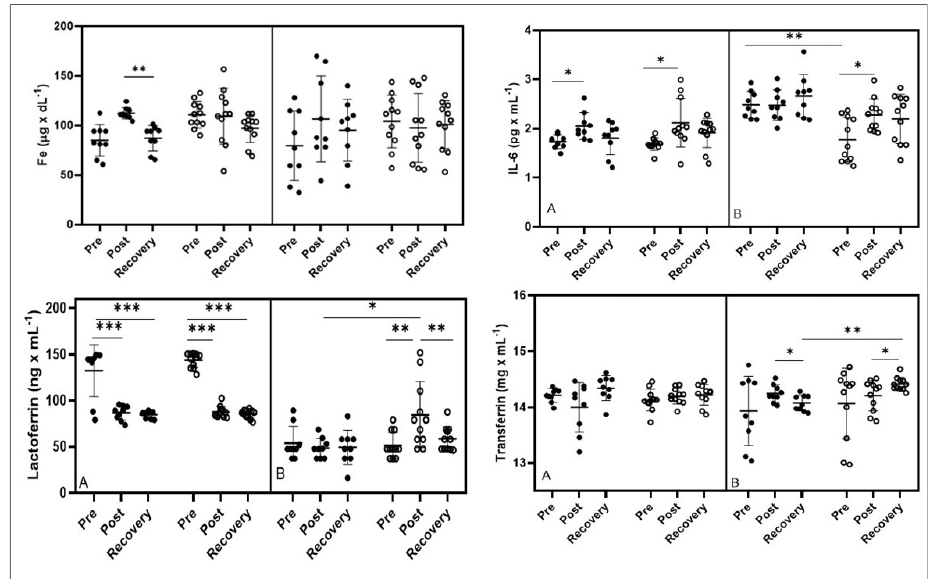
Figure 4. Effect of bovine colostrum supplementation Fe-iron; IL-6-interleukin 6, lactoferrin, and transferrin concentrations during exercise test performed before ( A ) and after supplementation ( B ). Note. Values are presented as mean ± SD; placebo (black dots); colostrum group (white dots); * p < 0.05 ** p < 0.01 *** p < 0.001. In the second stage of the study, there was also a significant negative correlation be- tween the concentration of TBARS and iron in the colostrum group after supplementation (r = − 0.4267; p = 0.0452); at the same time, no correlation was found in the placebo group (Figure 5).